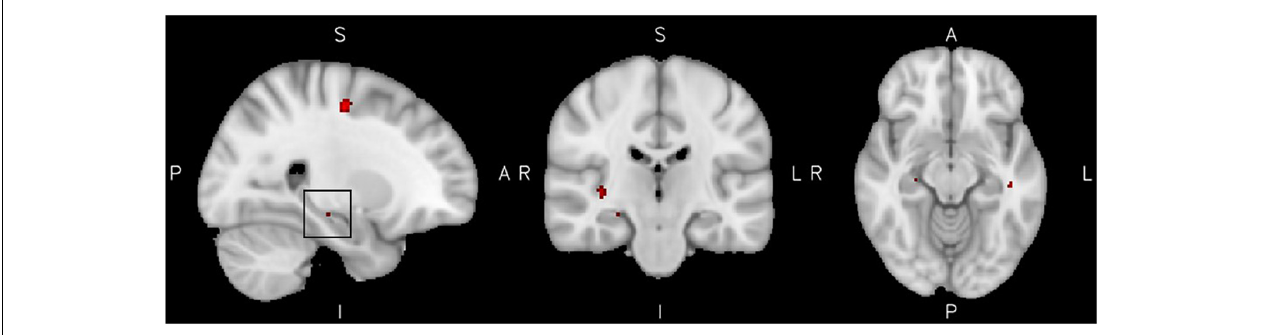
FIGURE 2 | High reactive aggression in ADHD. Results from the reactive aggression analysis in the ADHD group at the maximum of the cluster of 14 voxel in the hippocampus, highlighted by a black square in the left figure (slices x = 26 left, y = − 22 middle, and z = − 12 right), at a cluster extent correction of p = 0.05.